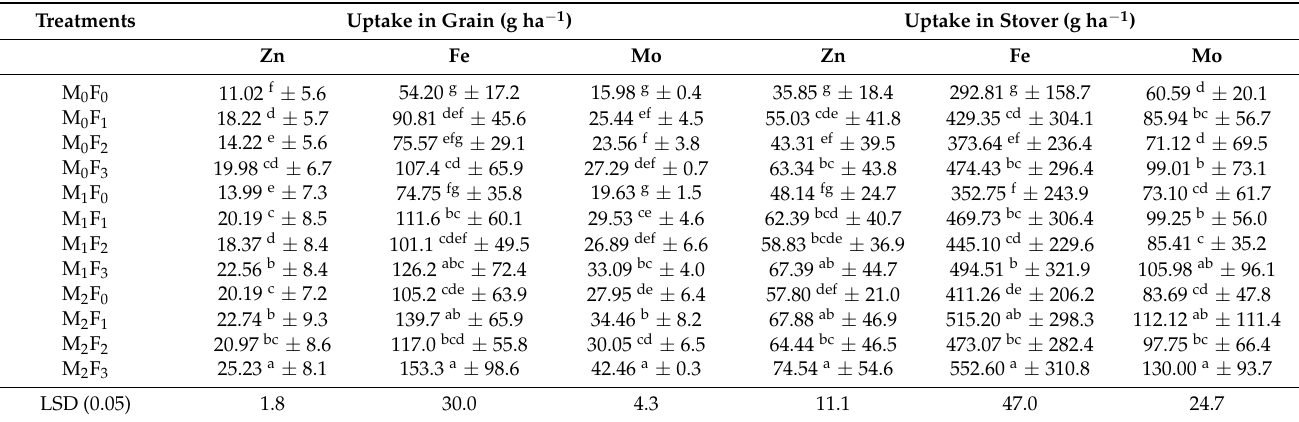
Table 4. Effect of the application of Zn, Fe and Mo molecules on the uptake of micronutrients in the grain and stover of cowpea.